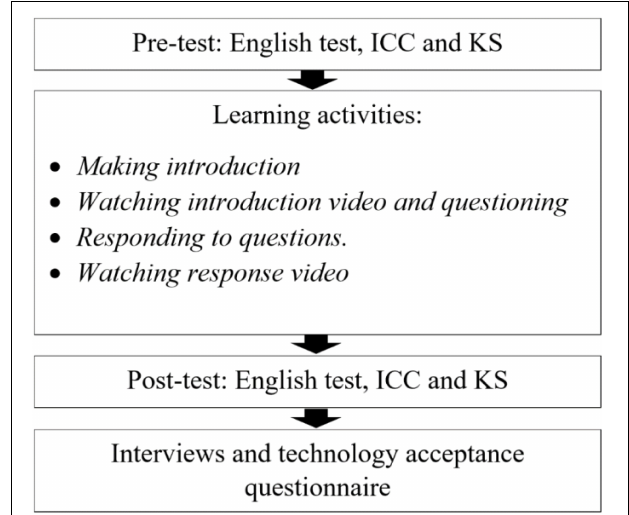
FIGURE 3 | Research